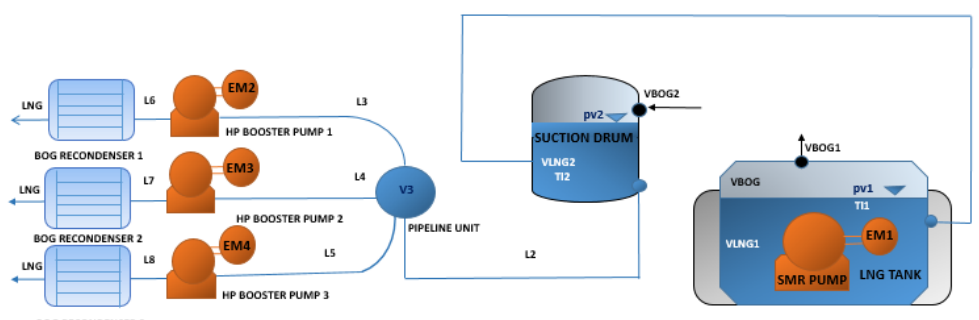
Figure 1. Simplified scheme of LNG transportation system in the FSRU. Note: L1, L2, L3, L4, L5, L6, EM3, EM4—electric motor indexes of pumps; pv1—vapor pressure in the LNG tank; pv2—vapor pressure in the Suction Drum; TI1—LNG temperature in the LNG tank; TI2—LNG temperature in the Suction Drum.